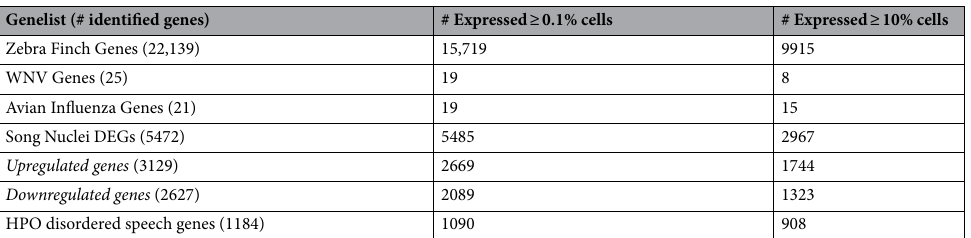
Table 1. Expression of gene lists related to different research fields utilizing zebra finches. See Supplementary Table 4 for further expression statistics. Abbreviations: WNV, West Nile Virus; DEG, differentially expressed gene; HPO, Human Phenotype